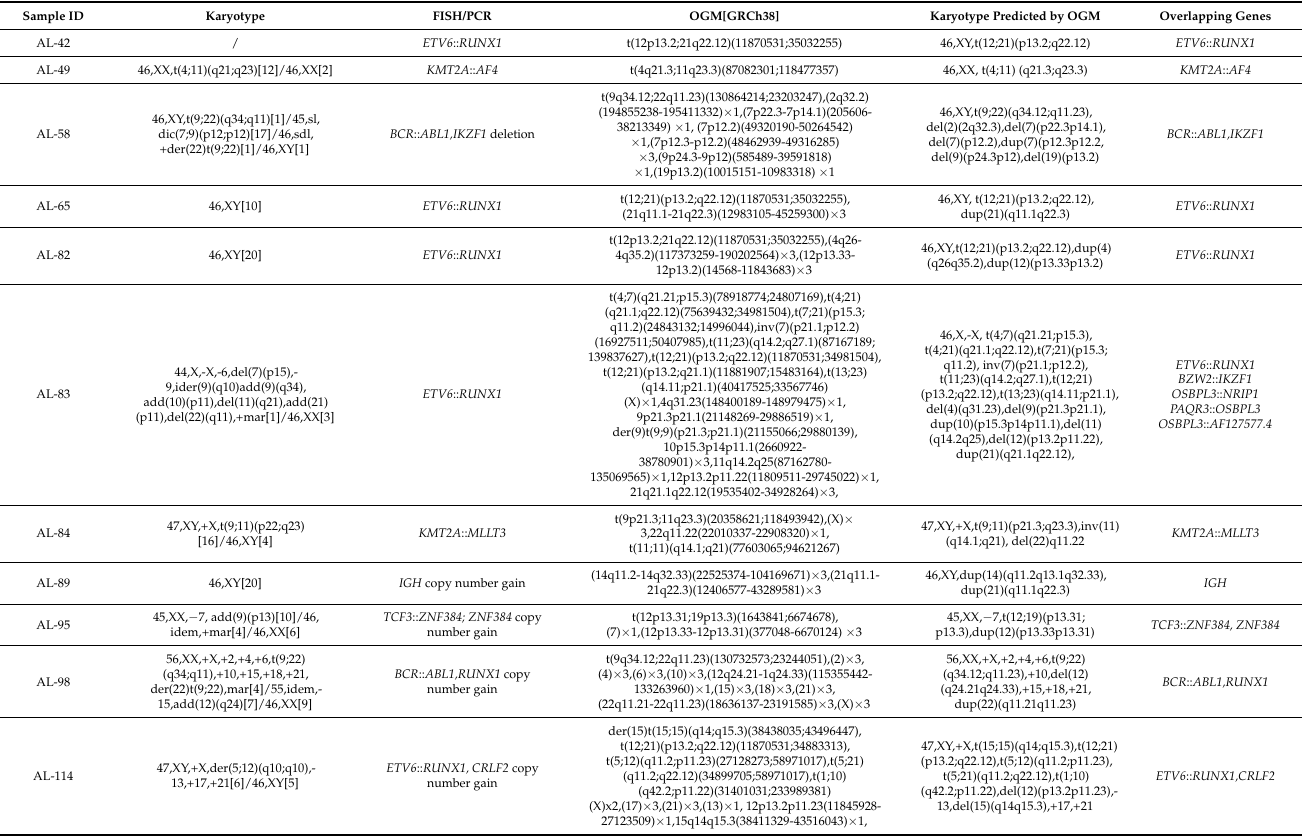
Table 4. OGM identified all SVs detected by conventional technologies.